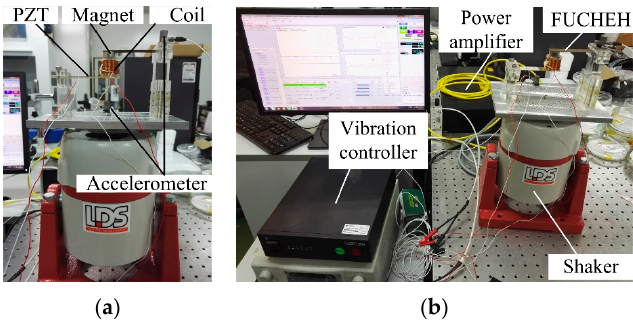
Figure 6. ( a ) Prototype of the FUCHEH; ( b ) Experimental system for the FUCHEH.